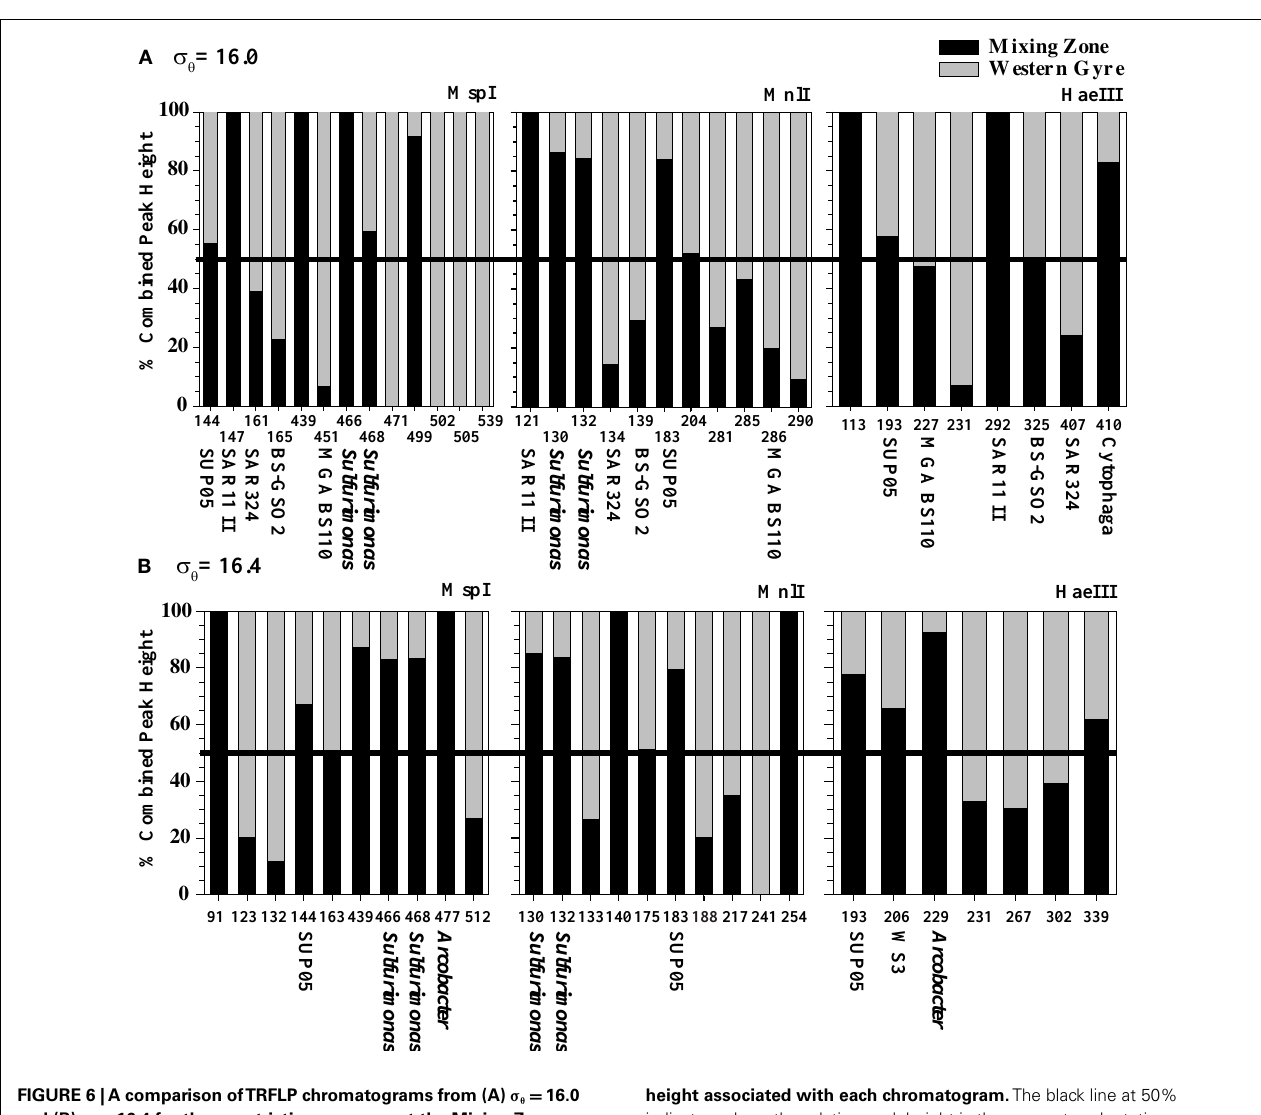
FIGURE 6 |A comparison ofTRFLP chromatograms from (A) σ θ = 16.0 and (B) σ θ = 16.4 for three restriction enzymes at the Mixing Zone Station (black) and theWestern Gyre (gray) where the x -axis displays differentTRFLP peaks and the y -axis is the percent of peak